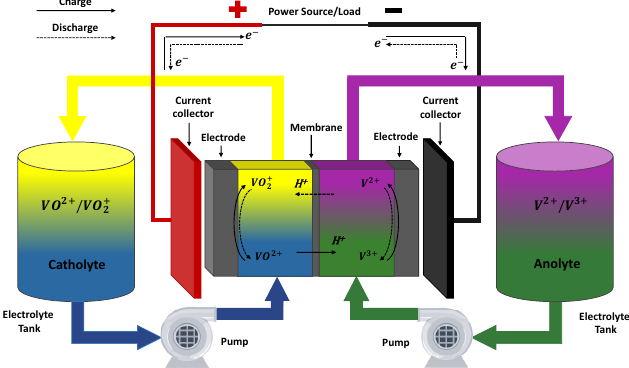
Figure 1. General scheme of a VRFB and its main